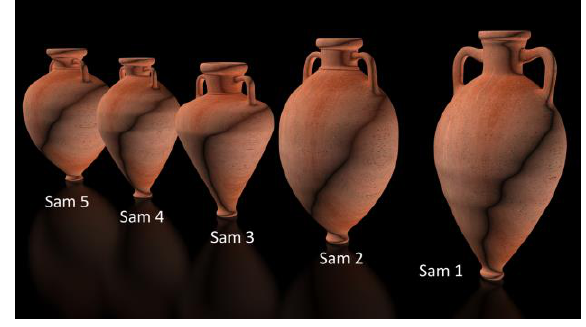
Figure 13. A group Samian amphoras from 7 th -5 th century